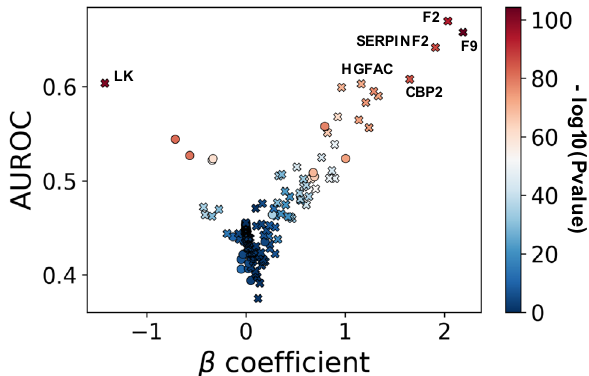
Figure 2. Clinical and protein predictive markers of patient survival after transplant. Post-transplant survival prediction, by Monte Carlo Cross Validation (see “Methods”), of the 181 proteins and 37 binarized clinical characteristics. Protein (crosses) and clinical (circles) marker association (beta coefficient; a measure of influence towards patient survival) versus predictive performance (AUROC). A L1-regularized logistic regression model estimated the association (beta coefficient) of each marker to post-transplant patient survival. The diverging color palette indicates the negative log10 of the feature importance significance or p-value, after Bonferroni correction, from a permutation analysis. The significantly predictive markers with an AUROC > 0.6 are labelled.